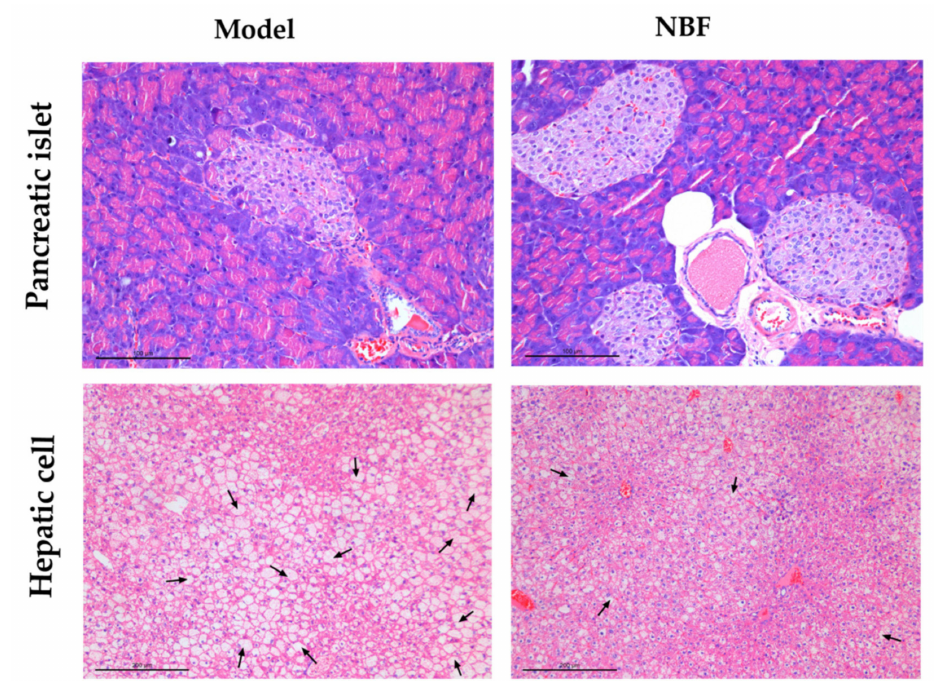
Figure 8. Histopathological section of the pancreas and liver in db/db mice. The pancreas ( × 100 magnification) and liver ( × 200 magnification) were measured by H&E staining. Model: dia- betic mice untreated; NBF: diabetic mice treated with NBF at 200 mg/kg; The arrow points to the extensive vacuolar